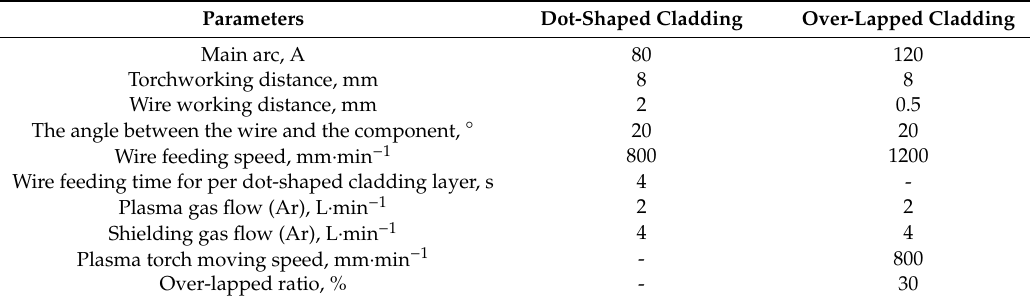
Table 2. Main parameters for the PTA cladding process. Parameters